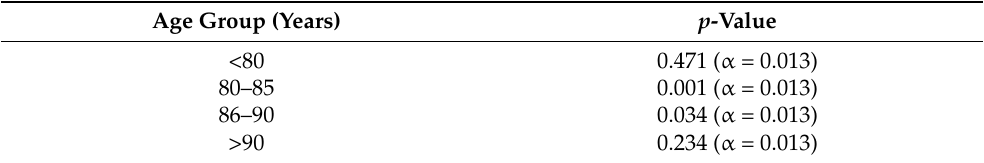
Table 4. Comparison of pre-COVID and during-COVID PA for different age